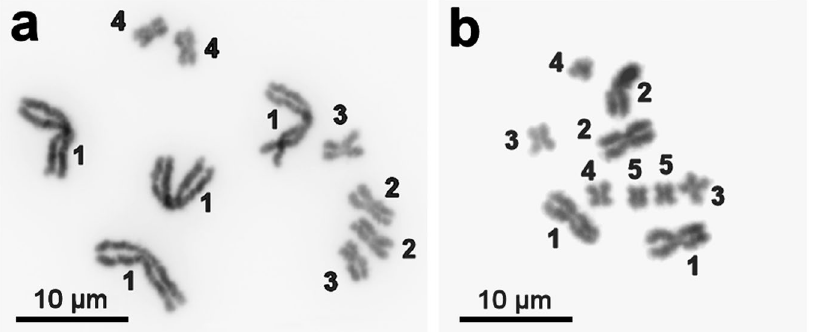
Figure 1. Metaphase spreads of M. lignano ( a ) and Macrostomum sp. 8 ( b ). ( a ) A metaphase spread of the M. lignano line DV1/10 with 2n = 10 (4 m + 2 m + 2 m + 2 m). The modified technique used here allowed us to obtain high-quality chromosome spreads and to also reliably identify chromosome 2 (MLI2). ( b ) A metaphase spread of Macrostomum sp. 8 with 2n = 10 (4 m + 2 m + 2 m + 2 m). The chromosomes are designated by Arabic